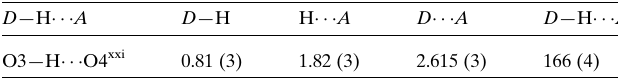
Table 3 Hydrogen-bond geometry (A˚ , (cid:3) ) for TlFe(HAsO 4 ) 2 .